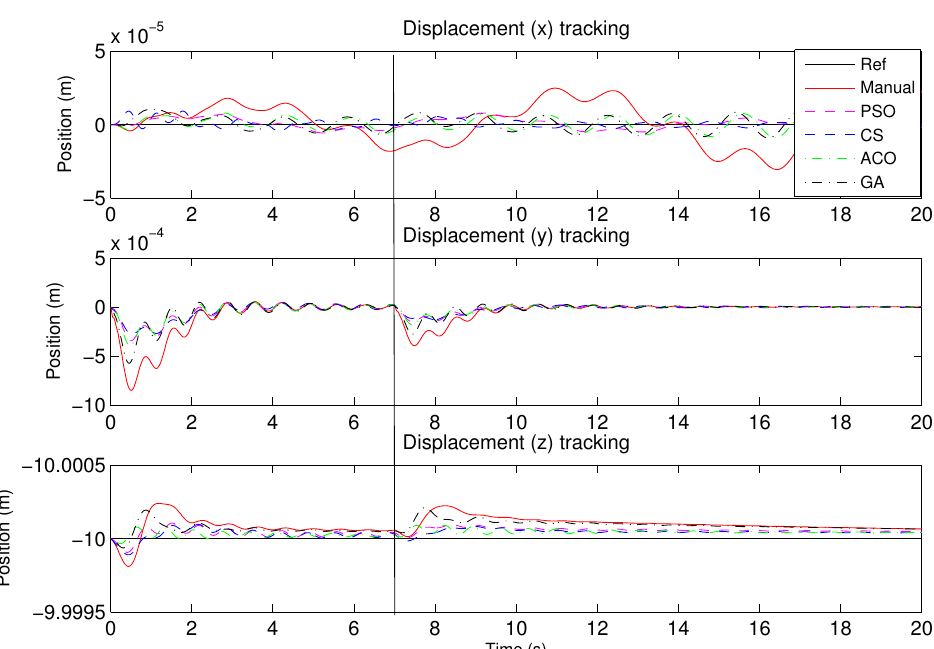
Figure 14. The position history of the rotorcraft subjected to starboard gust disturbance at hover.